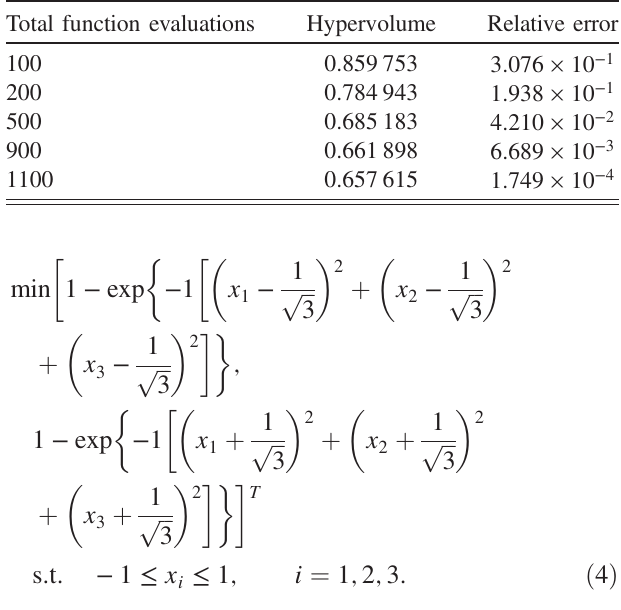
TABLE I. Convergence of benchmark problem with errors relative to hypervolume of sampled reference solution.